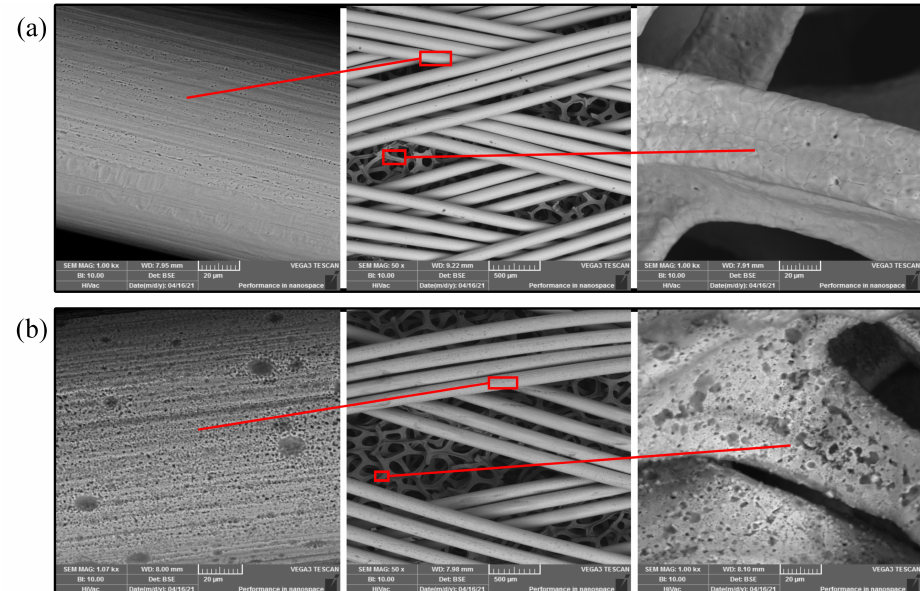
Figure 3. SEM image of composite wick. ( a ) Untreated composite wick; ( b ) Composite wick after wettability modification.